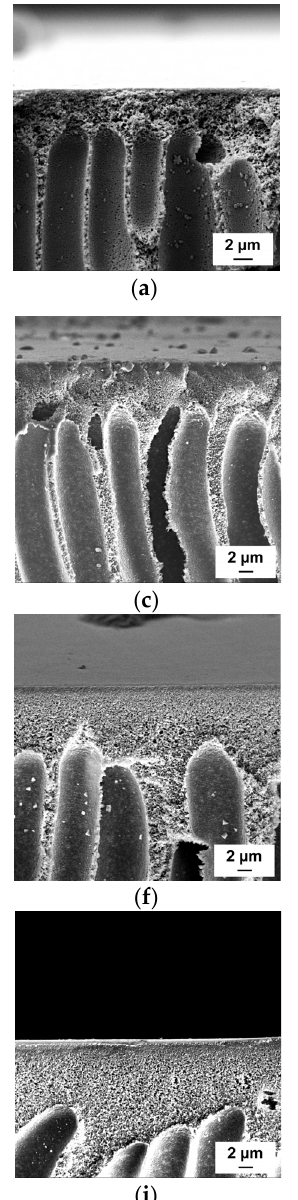
( j ) Figure 2. SEM micrographs of the cross ‐ sections of the reference PSF membrane ( a ) and mem ‐ branes, modified by the introduction of PAA to the precipitation bath ( b – j ): ( a ) PA ‐ 0; ( b ) PA ‐ 100 ‐ 1.0; ( c ) PA ‐ 250 ‐ 1.0; ( d ) PA ‐ 450 ‐ 1.0; ( e ) PA ‐ 100 ‐ 1.5; ( f ) PA ‐ 250 ‐ 1.5; ( g ) PA ‐ 450 ‐ 1.5; ( h ) PA ‐ 100 ‐ 2.0; ( i ) PA ‐ 250 ‐ 2.0; and ( j ) PA ‐ 450 ‐ 2.0. It was revealed that pore size and porosity significantly go down with a rise in PAA molecular weight and concentration (Figure 4). The pore size of membranes modified